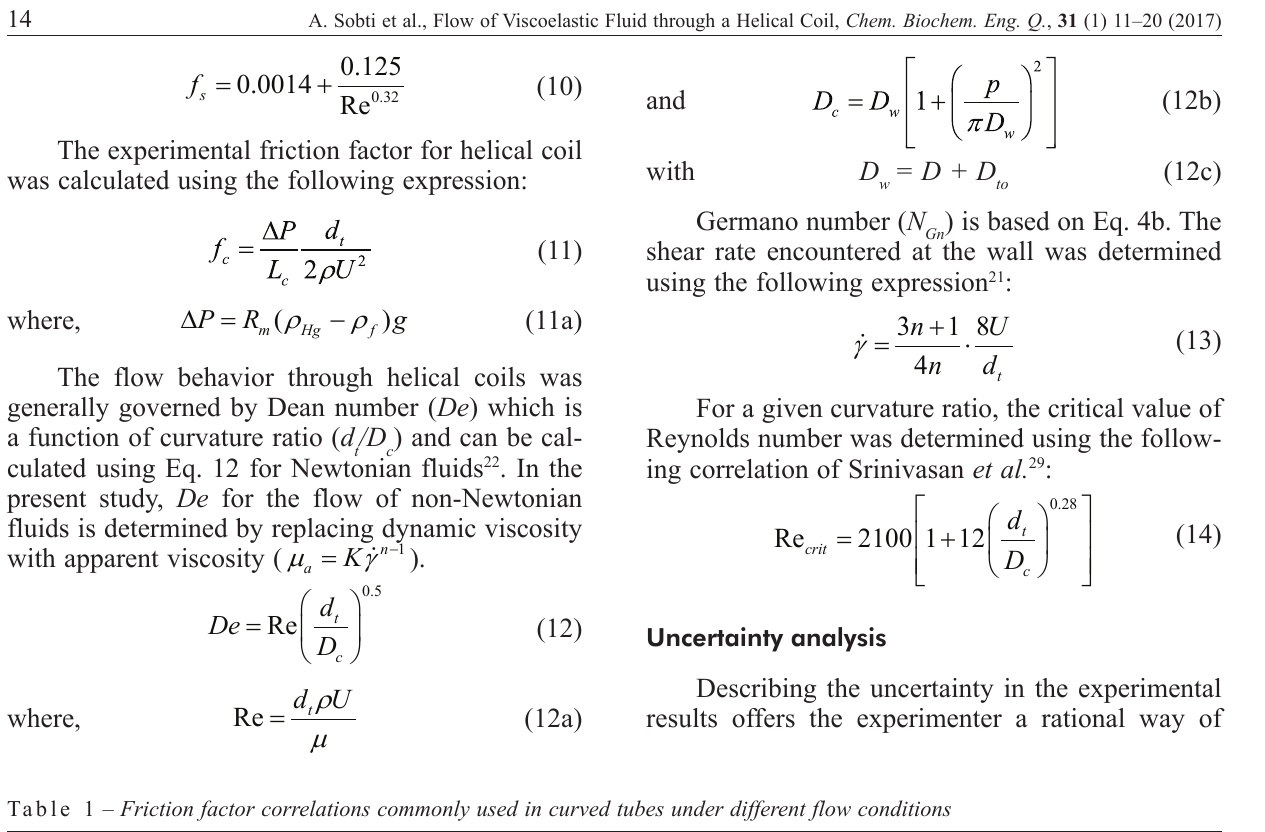
– Empirical correlation for non-Newtonian fluids where modified Dean number is defined on basis of viscosity prevailing at the mean wall shear stress.